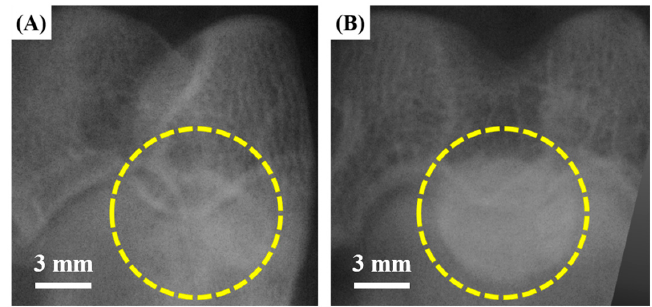
Figure 10. Representative X-ray images captured from ( A ) PMMA containing barium sulfate and ( B ) PMMA/HA composite with an HA content of 40 vol %, immediately after implantation into defects created in the femoral condyles of rabbits. Dashed lines indicate the bone cements in the defects.